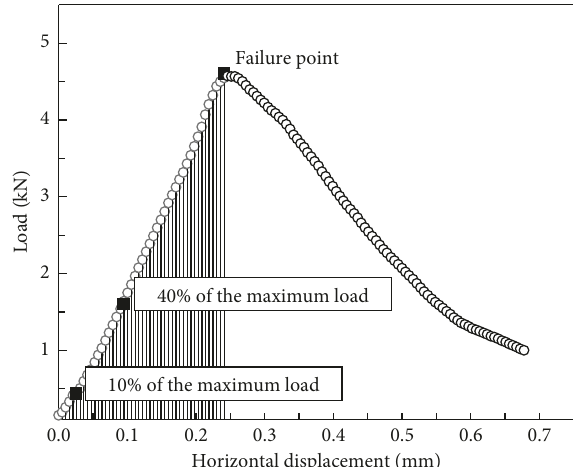
Figure 3: Typical curve of force-horizontal